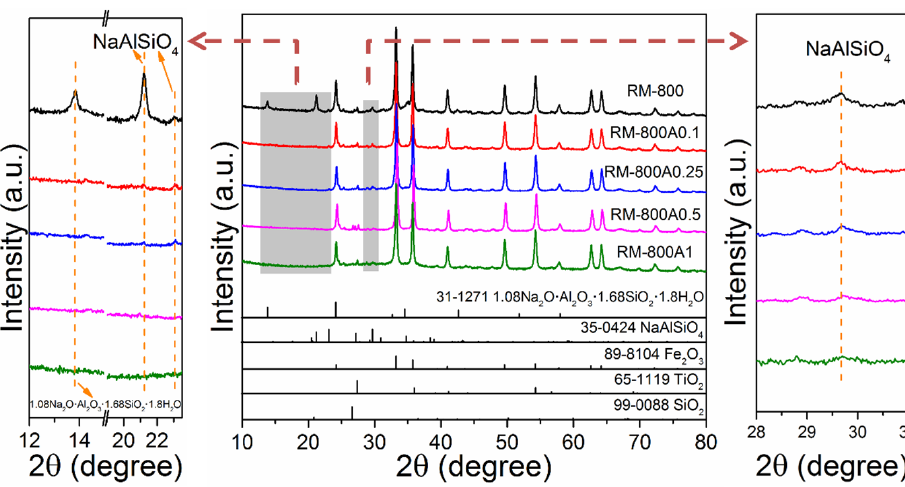
Figure 6. XRD patterns of the RM-800 sample after acid leaching with different concentrations. Table 2. The pH of leachate and the relevant weight loss of leached red mud samples.